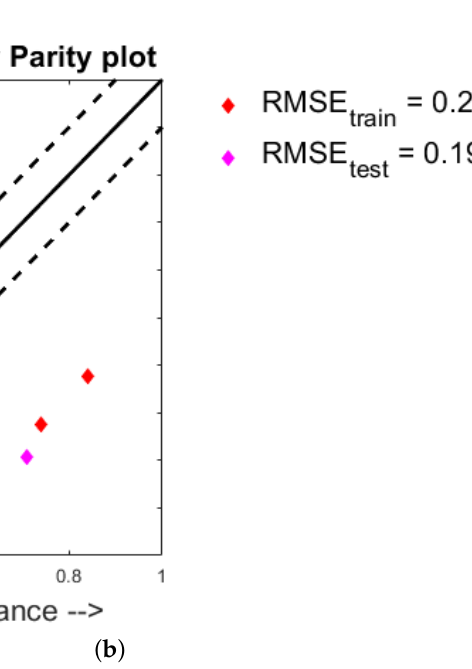
Figure 4. Experimental observations (X) vs. predicted model responses (Y) for RT metrics when the model is trained trained Kumar et al., 2016 [19] dataset. ( a ) MRT; ( b ) variance. From Figure 5, the model predictions for the normalized variance for a model frame- work without having any axial dispersion incorporated can be seen. It can be seen that the variance can be predicted in a very narrow range of 0.1–0.2, thereby showing a worse prediction for the variance and thus the necessity of having localised variance dependent dispersion flow.